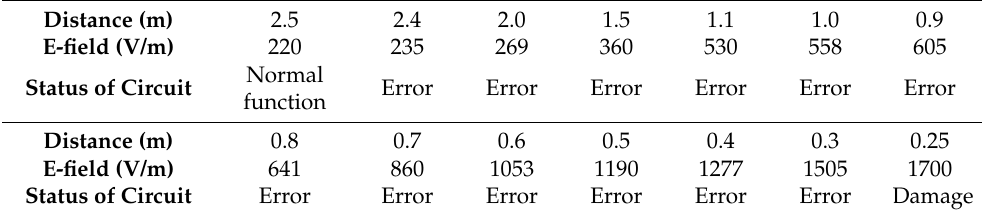
Table 3. Results for EMP immunity of a circuit with IC